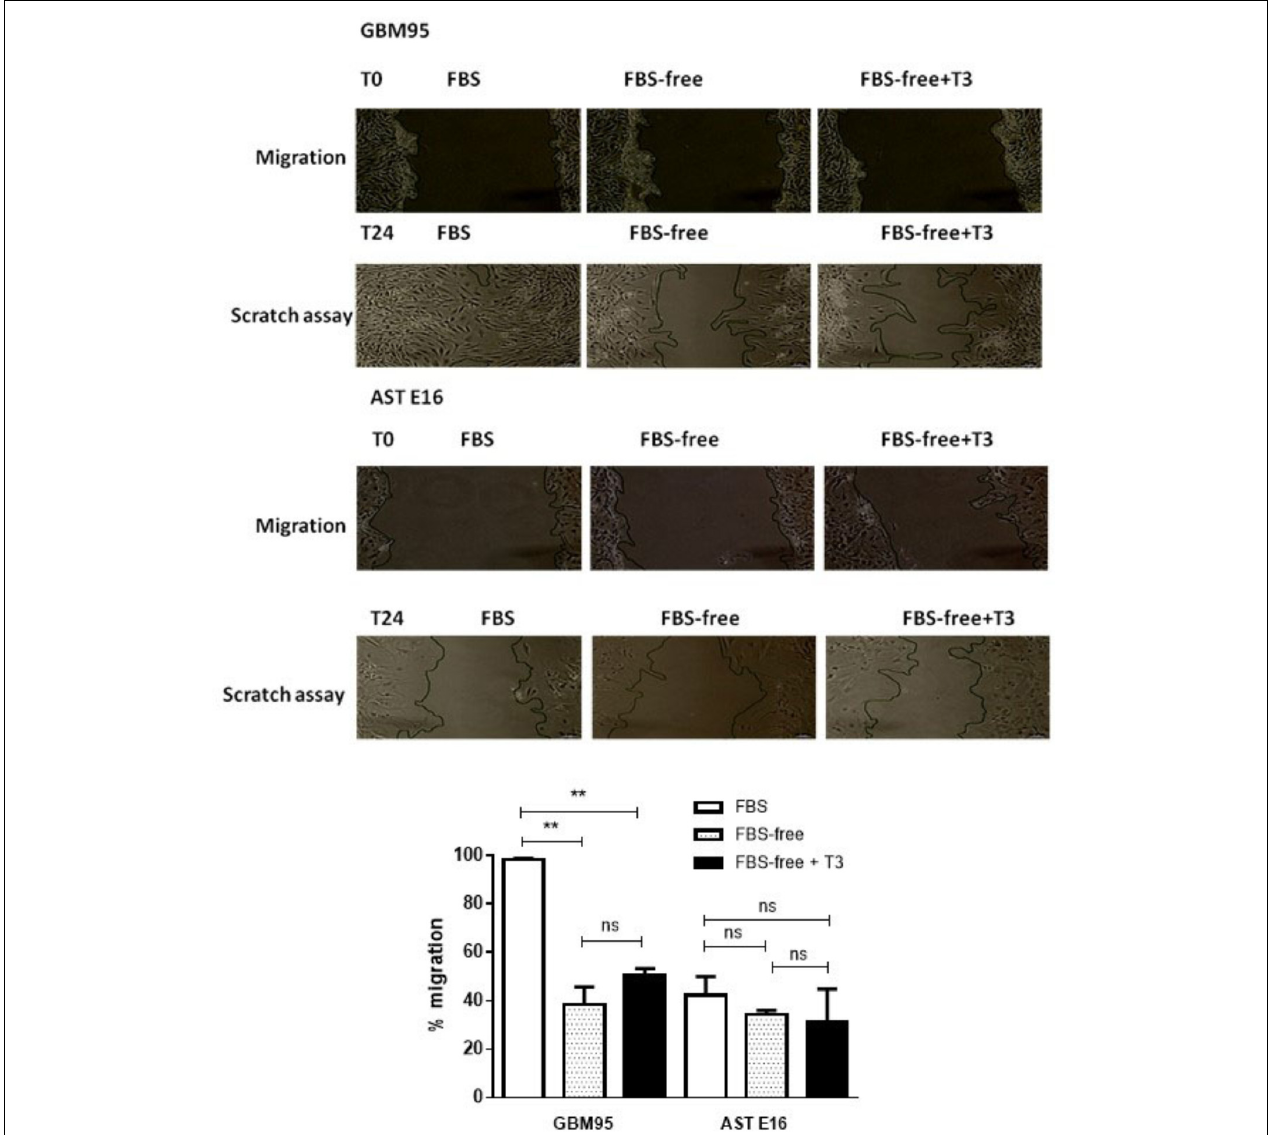
FIGURE 6 | (Upper) Analysis of cell migration in GBM-95 cells and cultured E16 astrocyte cells. The migration and invasion of the GBM cell line was not significantly altered by treatment with T3, whereas the migration of cultured astrocytes was significantly decreased by 24.47% in response to treatment with T3. (Lower) Cell migration assay of GBM-95 cells and cultured E16 astrocytes treated with T3. Assay measurements were performed at two different time points: T0, represents the beginning of the treatment and T24 represents 24 h after the start of treatment. Cells were cultured in medium containing 10% FBS, medium without serum (FBS-free), and treated with T3 in medium without serum (FBS-free+T3). The images were analyzed by measuring the reduction in scratch area ( ∗∗∗ P < 0.001: one-way